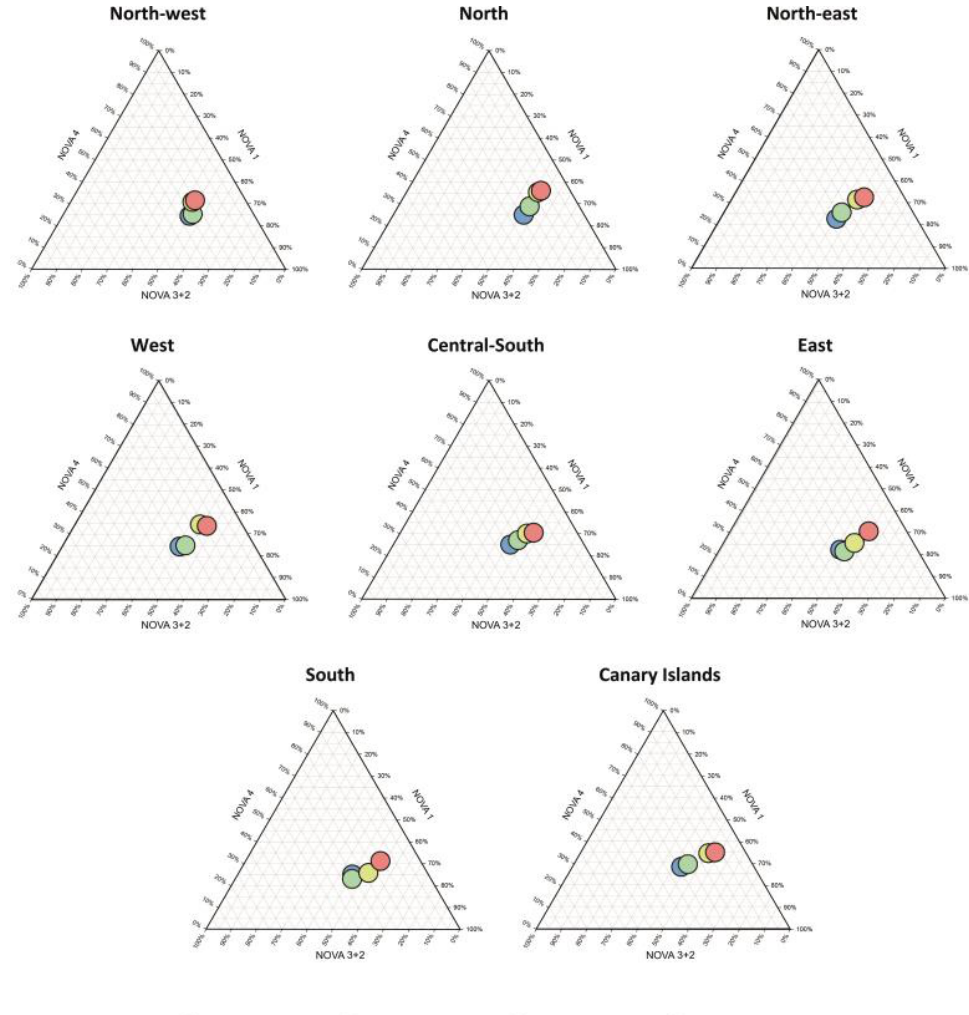
Figure 3. Ternary diagram of the average percentage of energy intake in the NOVA classification over time by geographical area of Spain.